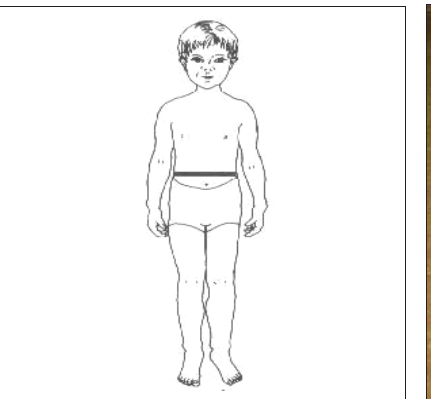
Figure 2. Sleight test (s) — 5 meters × 4